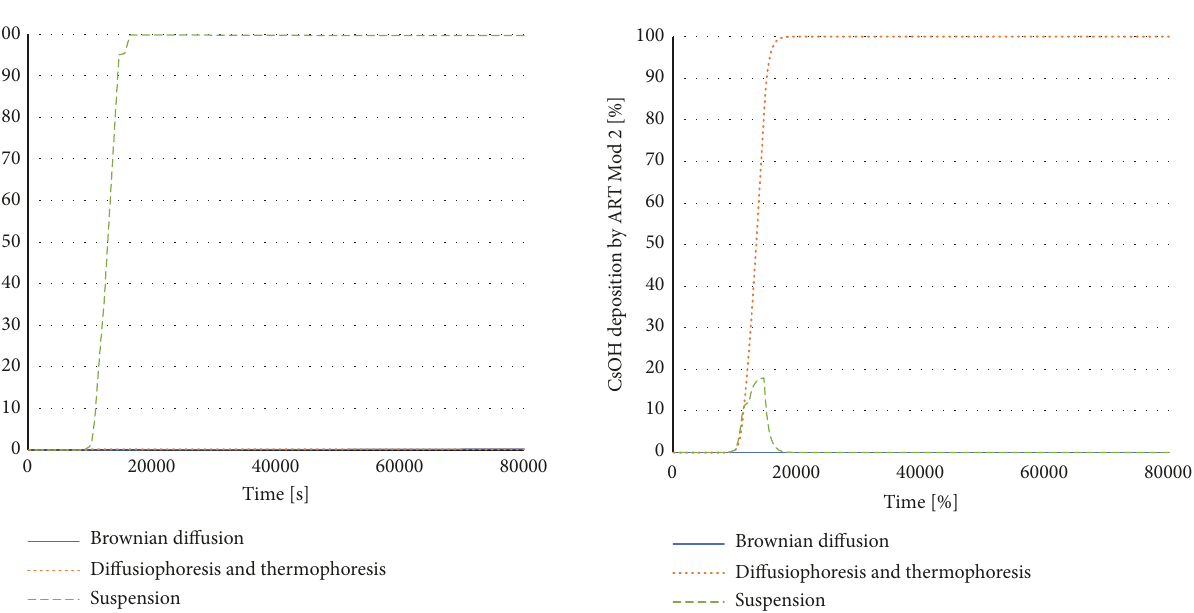
Figure 14: CsOH deposition in dry condenser volume calculated by ART Mod 2.